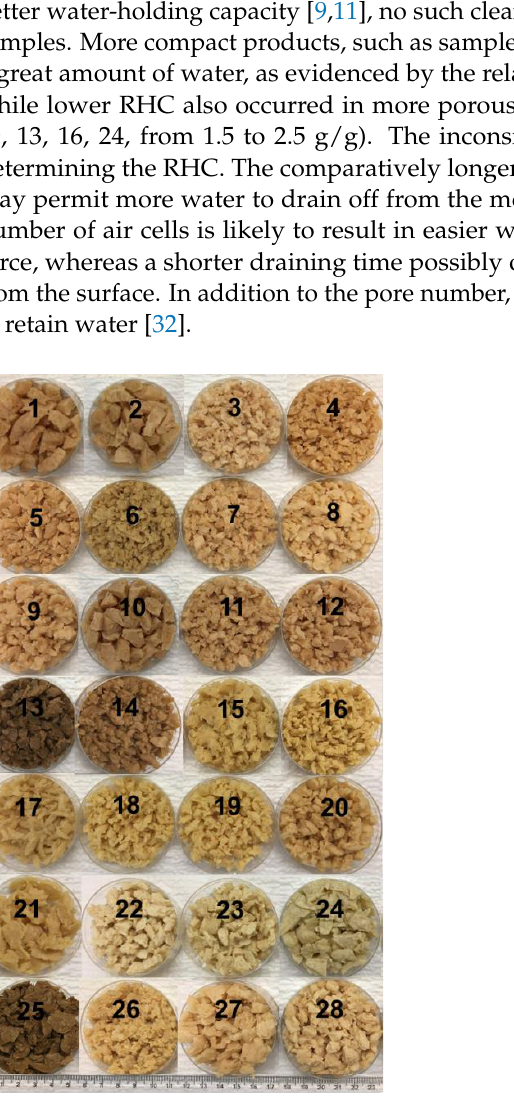
Figure 1. Visible appearance of different commercial TVPs. TVP types: 1 – 14: textured soy proteins; 15 – 21: textured pea proteins; 22 – 25: textured wheat gluten; 26: textured chickpea protein; 27: textured pea/chickpea mixed proteins; 28: textured pea/navy bean mixed proteins.